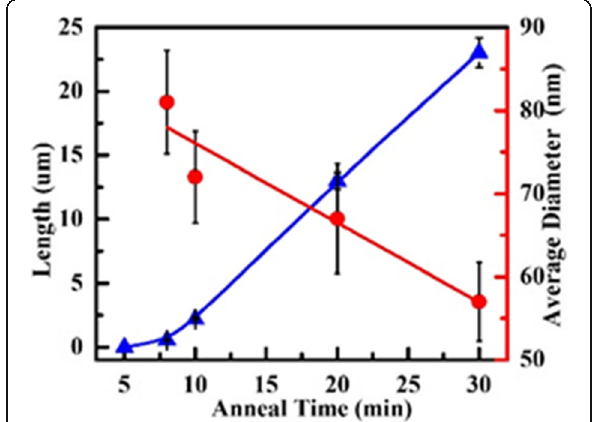
Fig. 9 The nanowire diameter and length as a function of the anneal time. Blue triangles and red circles in figure are the date for length and diameter of nanowire in experiment, and blue and red lines in figure were the fitting line according to the experiment dates